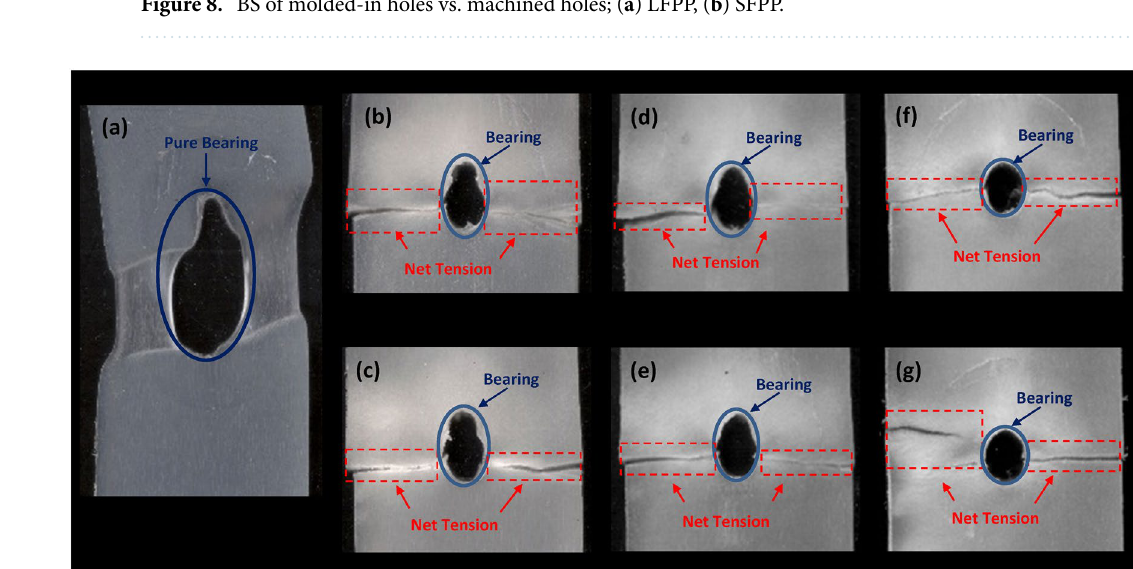
Figure 9. Failure morphologies of molded-in hole specimens tested in bearing; ( a ) Neat PP, ( b ) 10 wt% GF (12 mm initial length) + 90 wt% PP, ( c ) 10 wt% GF (24 mm initial length) + 90 wt% PP, ( d ) 20 wt% GF (12